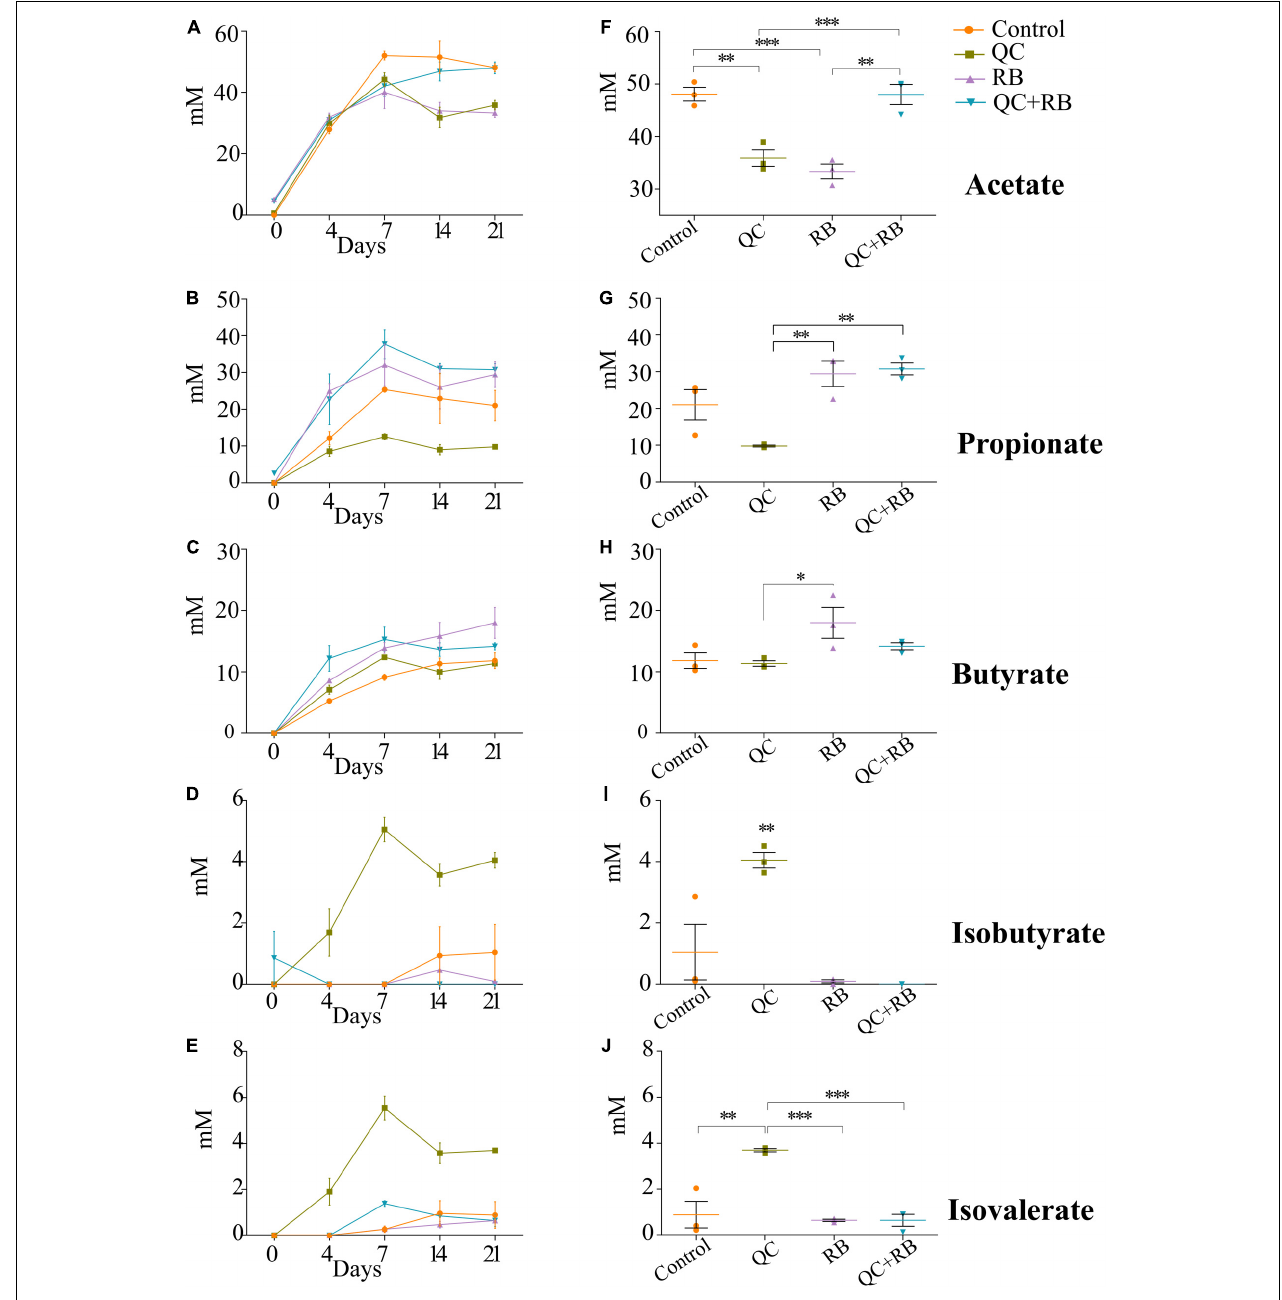
FIGURE 4 | Effect of quercetin (QC) and rice bran (RB) on short Chain Fatty Acids (SCFAs) production in QC, RB, and QC + RB compared to control medium in minibioreactors. (A–E) Represent the periodic variation of acetate, propionate, butyrate, isobutyrate and isovalerate at day 0, 4, 7, 14, and 21, respectively. (F–J) Represent the comparison of concentrations of acetate, propionate, butyrate, isobutyrate and isovalerate, respectively, from control, QC, RB, and QC + RB medium at day 21 (endpoint). Kruskal–Wallis test was performed between the groups and post hoc (Dunn test) analysis was performed to identify the different significant groups. “*, **, and ***” represents significance at p < 0.05, p < 0.01 and p < 0.001 respectively. Error bars represent standard error of the mean of data obtained from three different bioreactors.